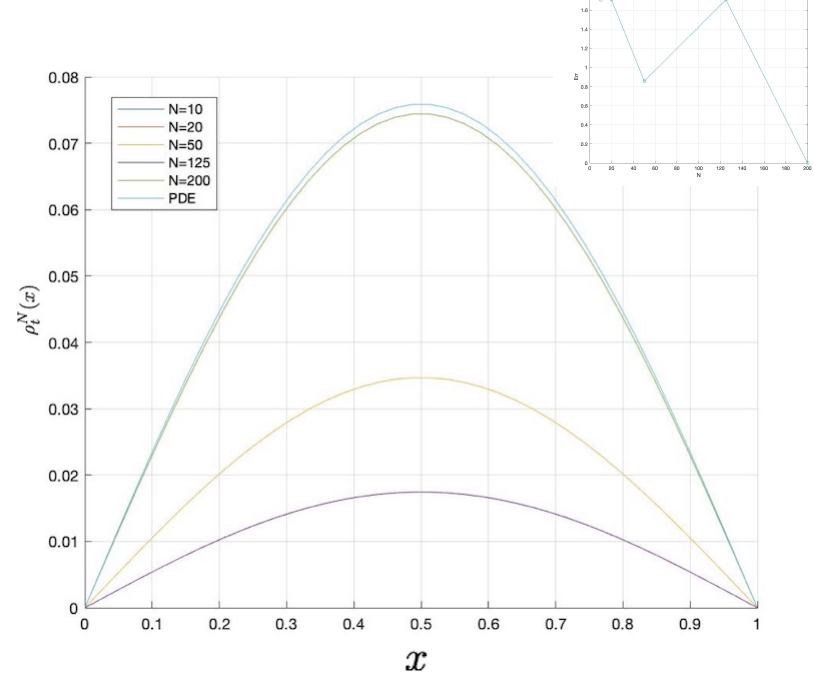
( x ) , solution of equation (61), for x with D = [ 0,1 ] , t = 1 t ∈ −